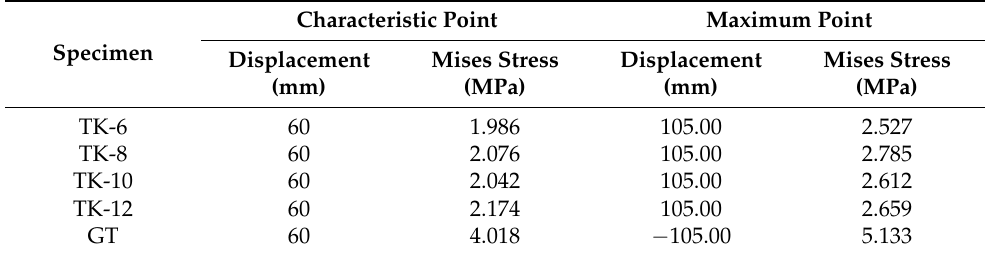
Figure 24. Stress clouds images: ( a ) TK-6; ( b ) TK-8; ( c ) TK-10; ( d )TK-12; and ( e ) GT. Table 6. ALC panel bolt hole stress. Table 6. ALC panel bolt hole stress.